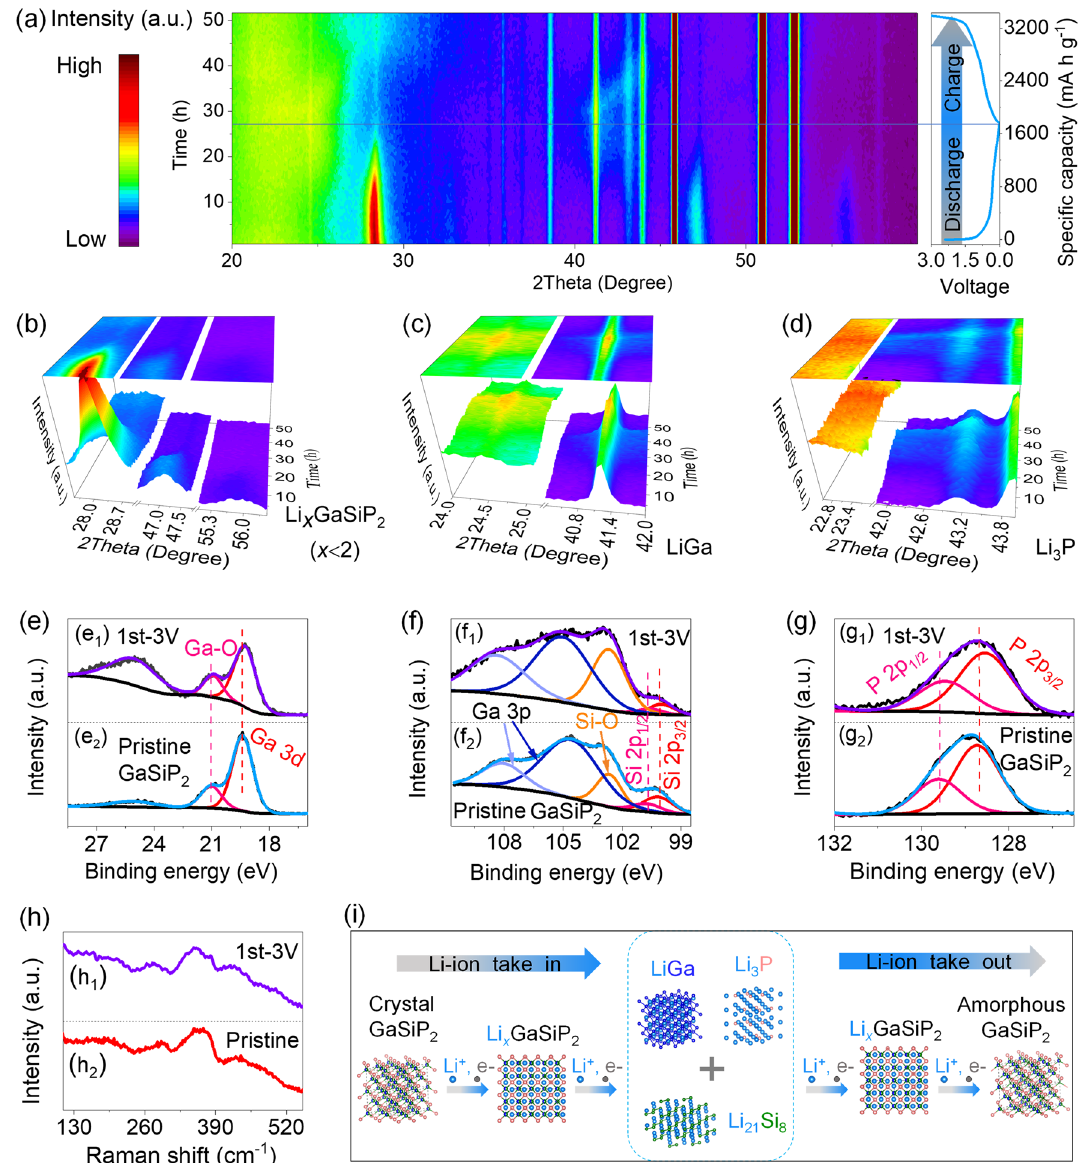
Fig. 6 a In situ XRD contour image along with the discharge and charge profiles of the cation-mixed GaSiP 2 ; b – d Evolution of the GaSiP 2 com- pound, LiGa and Li 3 P; e – g Ex situ XPS; h Ex situ Raman. i Schematic illustration of the Li-storage